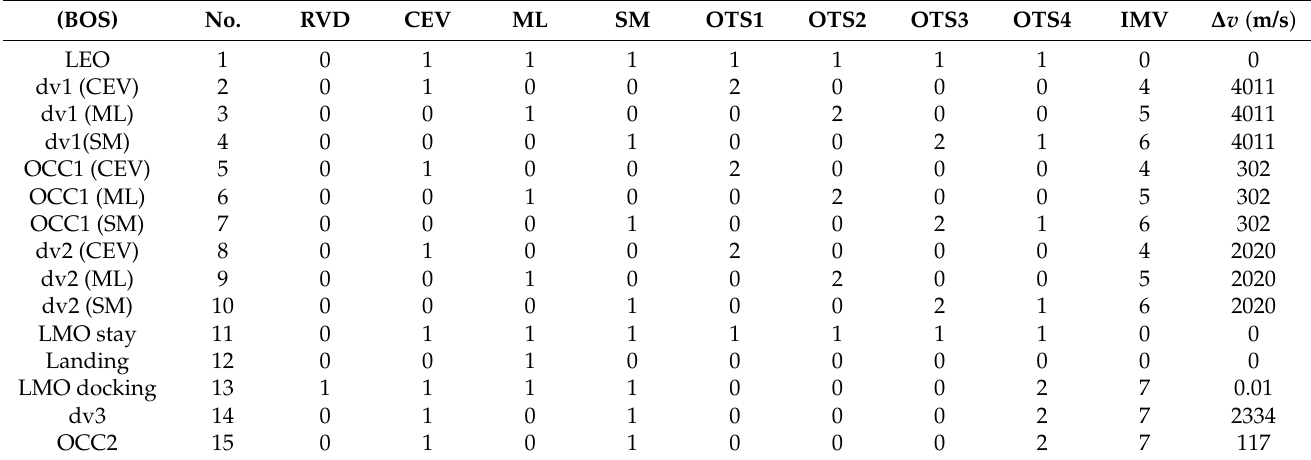
Table 9. Mission architecture matrix of Architecture-3.